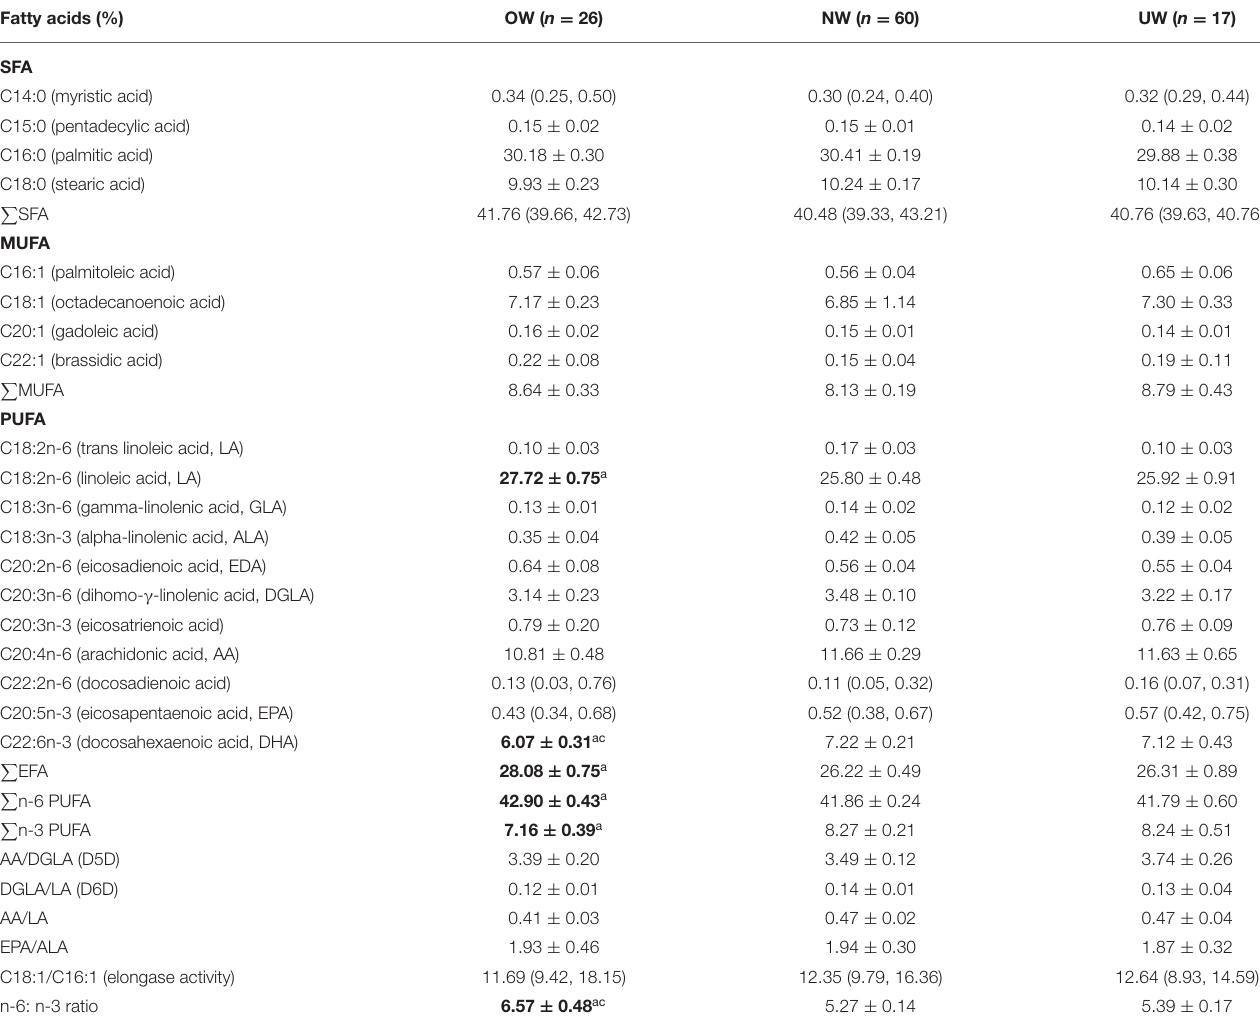
TABLE 2 | The fatty acid profile in maternal plasma according to maternal prepregnancy BMI. Fatty acids